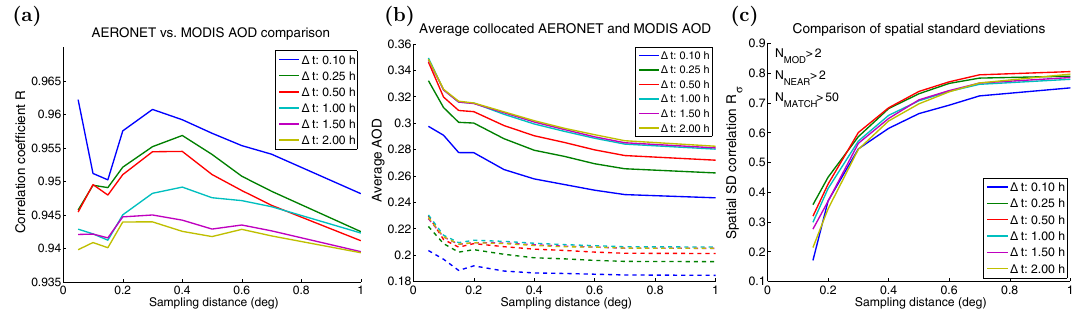
Figure 9. (a) Dependence of the AOD correlation R between AERONET and MODIS 10km product on the sampling distance. The colors indicate the temporal sampling window size. (b) Dependence of the average AOD for the matching cases on the sampling distance. on the sampling distance. The solid lines correspond to MODIS 10km product and dashed lines correspond to AERONET data. (c) Dependence of the AOD spatial variability correlation for the matching cases on the sampling distance. Here we have required at least three observations from each data source to calculate σ AOD , and the correlation coefficient is not shown of the number of matches is less than